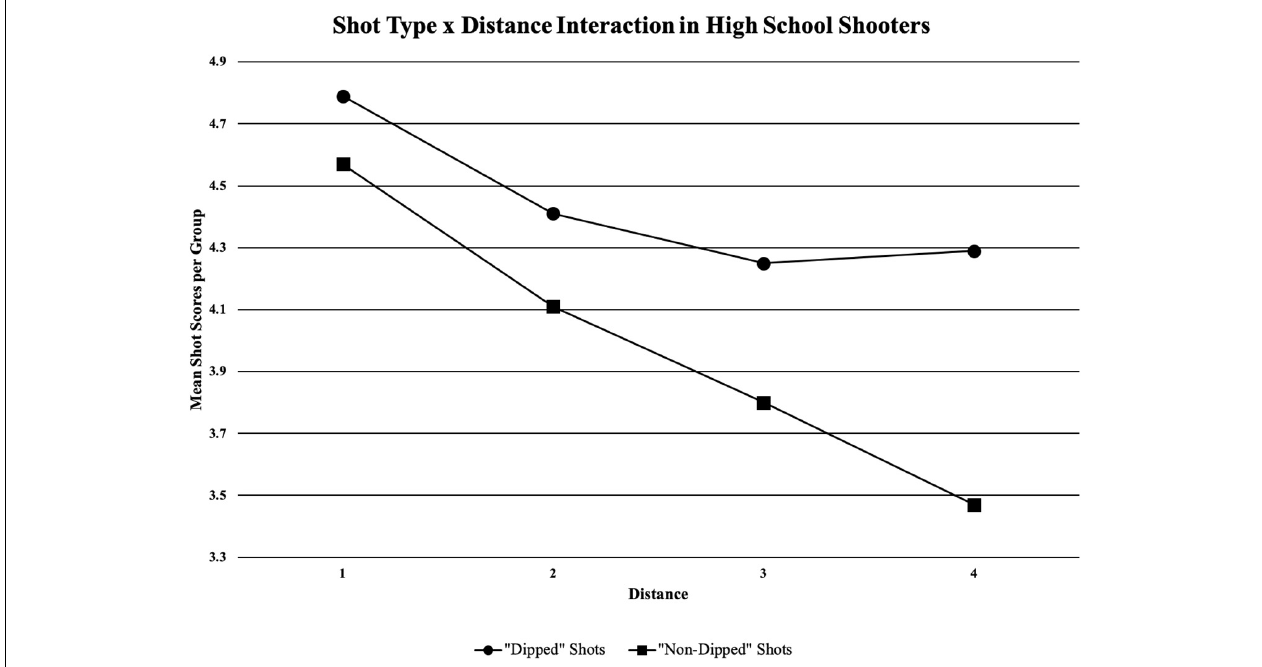
FIGURE 6 | Shot type (“dipped” and “non-dipped”) and distance interaction in high school shooters; significant results for “dipped” shots between distance 1 and 2 ( p = 0.009); distance 1 and 3 ( p = 0.002); distance 1 and 4 ( p = 0.004); significant results for “non-dipped” shots between distance 1 and 2 ( p = 0.002); distance 1 and 3 ( p = 0.000); distance 1 and 4 ( p = 0.000); distance 2 and 3 ( p = 0.011); distance 2 and 4 ( p = 0.000); distance 3 and 4 ( p = 0.008).